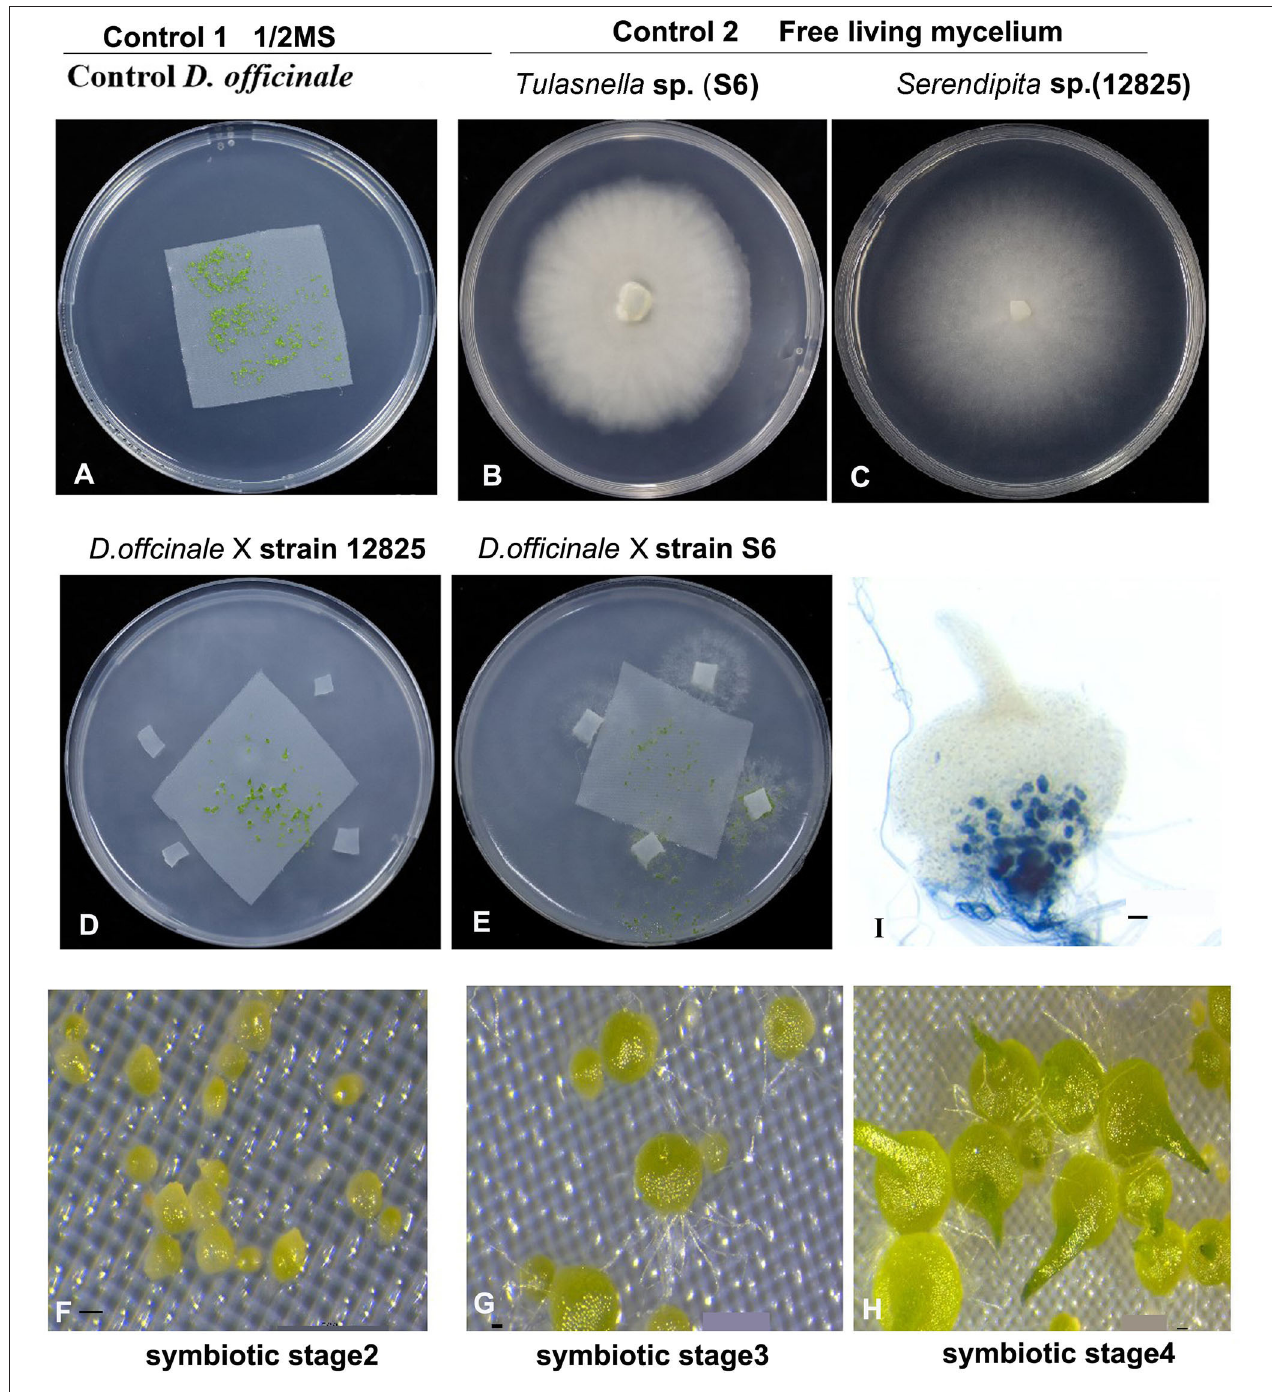
FIGURE 1 | Experiment designs for our study. Aymbiotic and symbiotic germination of medicinal orchid Dendrobium officinale inoculated with two mycorrhizal fungi Tulasnella sp. (S6) and Serendipita sp. (12825) at three development stages. (A) showing asymbiotic germination in 1/2MS medium as control; (B,C) The free-living mycelium of two fungi on PDA medium, respectively. (D–H) showing the symbiotic germination assay with two fungal species, respectively. (I) Trypan blue staining showing the pelotons in embryo cell in symbiotic stage 4 of D. officinale seed inoculated with strain 12825. Scale bar = 20 µ m in (F–H) , and 50 µ m in (I) . library preparation and sequencing. Briefly, clean reads TRAILING:3 SLIDINGWINDOW:4:15 HEADCROP:0 with the same UMI sequence were first clustered together, MINLEN:36). Clean reads were further treated with in- and then they were compared to each other using house scripts to eliminate duplication bias introduced in